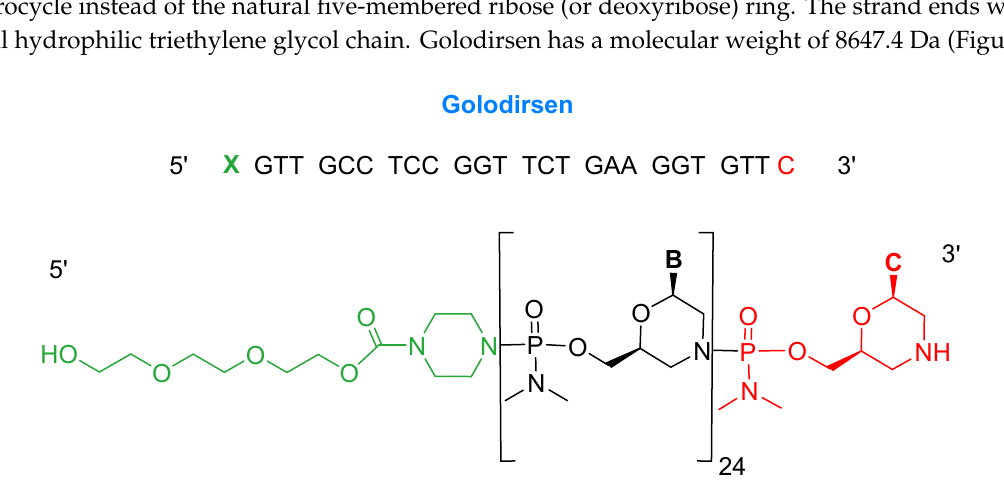
Figure 2. Chemical structure of golodersin (Vyondys 53 TM ).